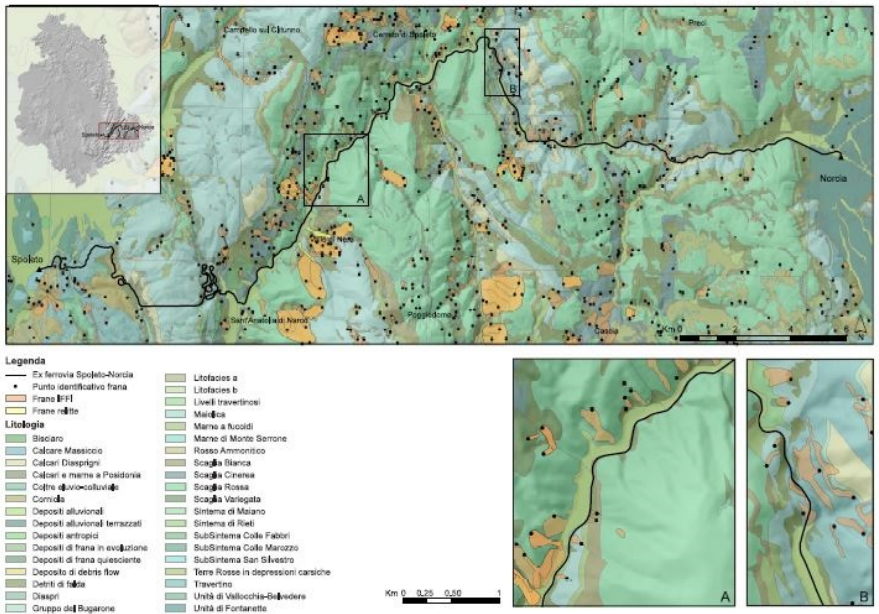
Figure 3. The greenway Spoleto-Norcia, the location of the slopes analyzed, and the soil types in the study area. The black dots represent the landslide points recorded in the IFFI